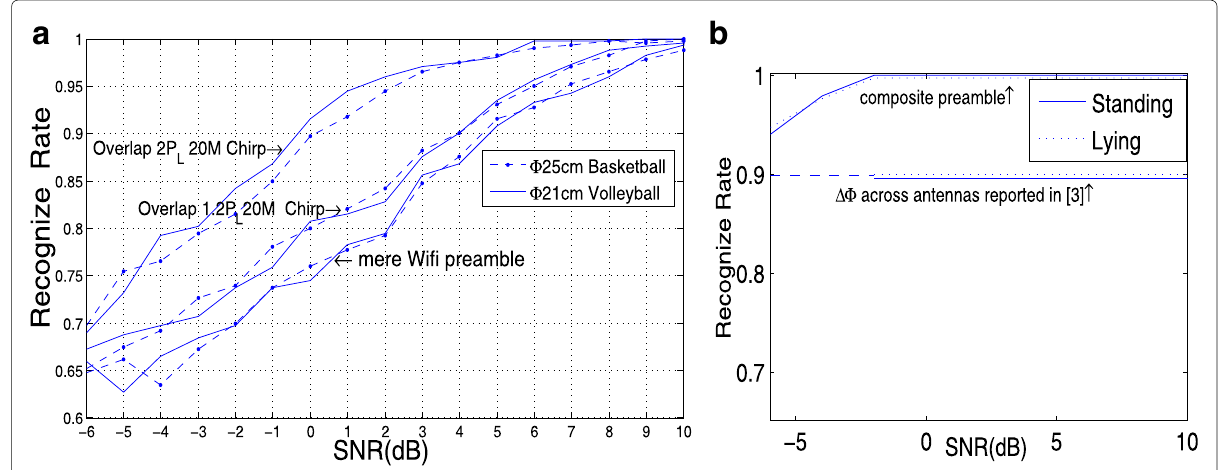
Fig. 9 Basketball/volleyball recognition and standing/lying recognition. a ball recognition; b standing/lying